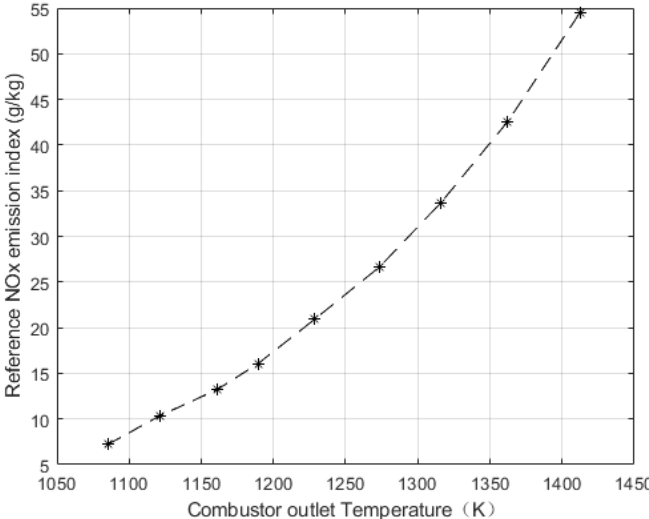
Figure 4. Relationship between CF6 engine combustor outlet temperature and reference NOx emis- sion